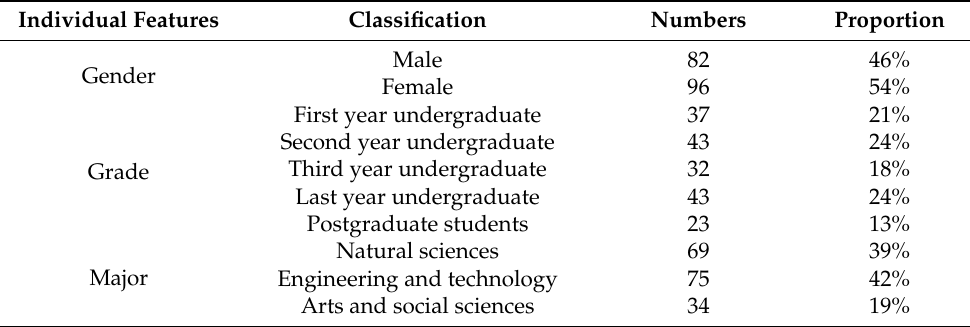
Table 2. The distribution of respondents’ individual